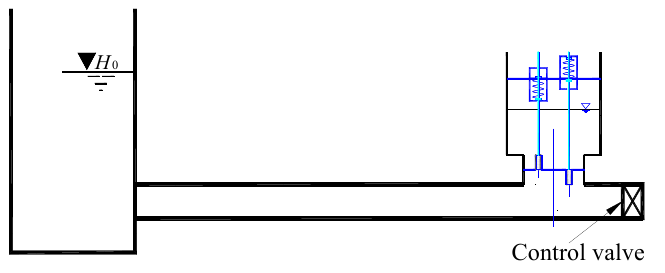
Figure 6. Intelligent surge tank in reservoir pipeline valve system.